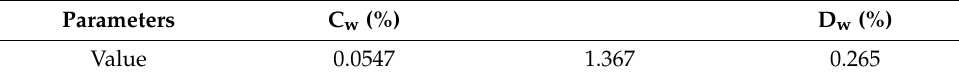
Table 4. Pubugou Dam materials wetting deformation model